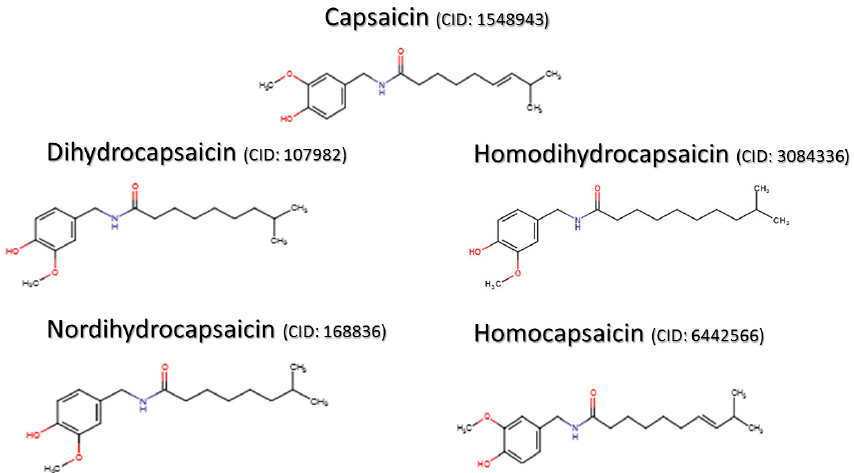
Figure 1. Chemical structure of capsaicin and capsaicinoids. Molecules of capsaicin and capsaicinoids available in PubChem database [12–16]. Compound identifier (CID) number is provided in parentheses. Molecules were drawn using Marvin JS, MarvinSketch in JavaScript.